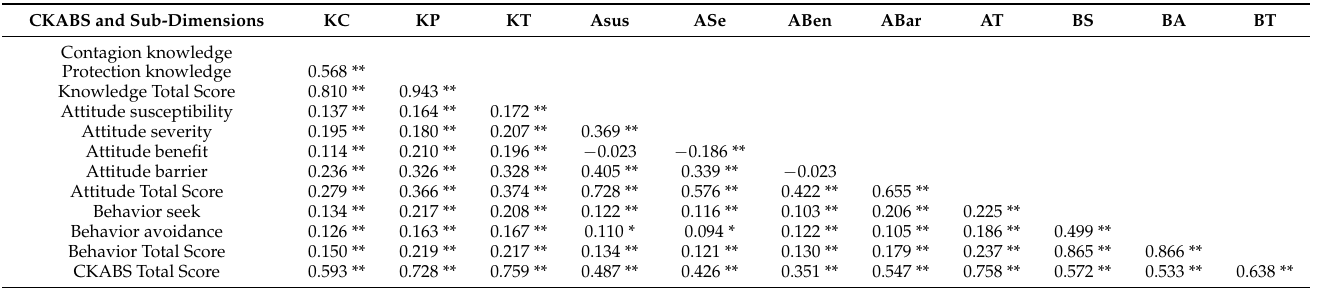
Table 5. Correlation Between CKABS Sub-Dimensions and Total Scores.